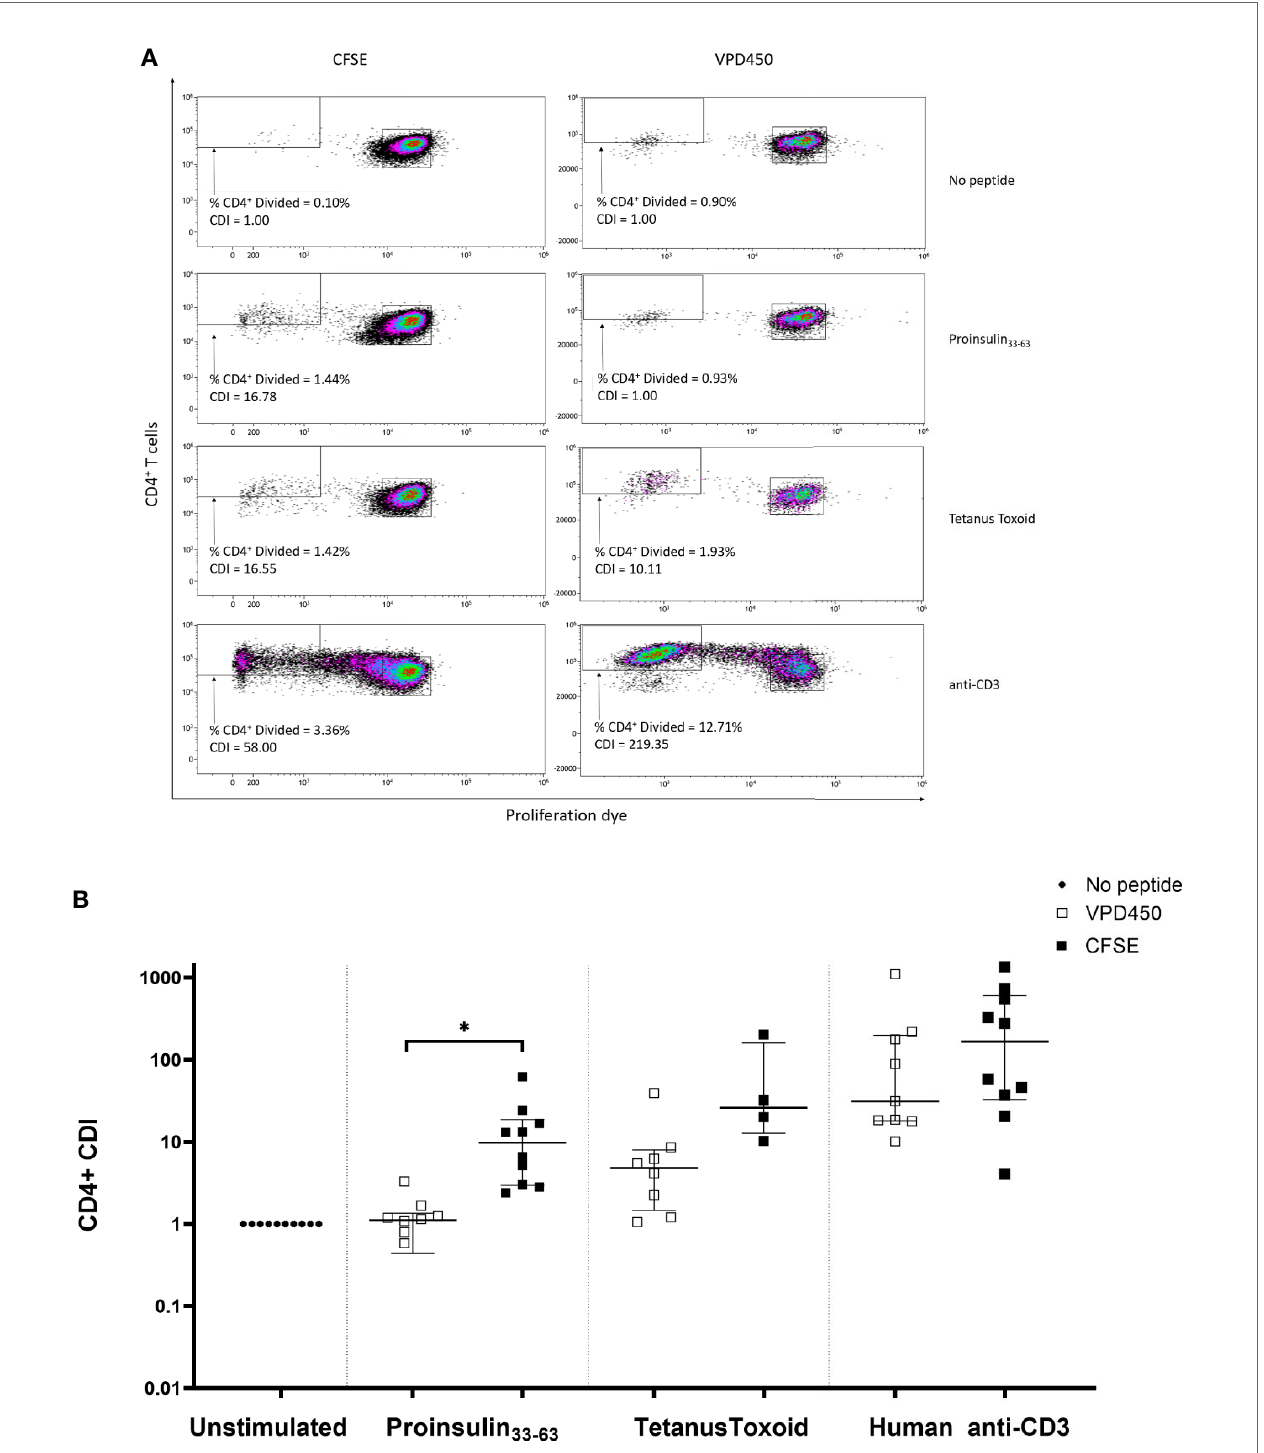
FIGURE 6 | Comparison of CFSE-based T-cell proliferation assay (concentration 0.05µM, staining time 5 min) and VPD450 assay (concentration 0.25mM, staining time 15 min) in freshly isolated PBMCs from subjects with T1D. (A) A representative patient in whom CDI was determined for CD4 + T-cells in response to no antigen, PI 33-63 , tetanus toxoid, and anti-CD3. (B) Combined data from 10 patients, each tested with VPD450 and CFSE-based T-cell proliferation assays. Each point represents a CDI from an individual patient. CDIs for no antigen, PI 33-63 and anti-CD3 are shown for all patients. CDIs for TT were measured for 10/10 and 4/10 patients using the VPD450 and CFSE-based T-cell proliferation assay, respectively. Error bars display median ± interquartile range. CDI for each CFSE-stained assay was compared to CDI for the corresponding VPD450-stained assay: *p < 0.05 paired t